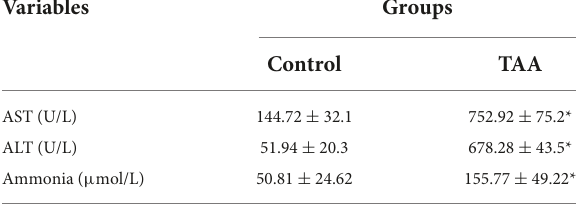
TABLE 1 Biochemical parameters in experimental